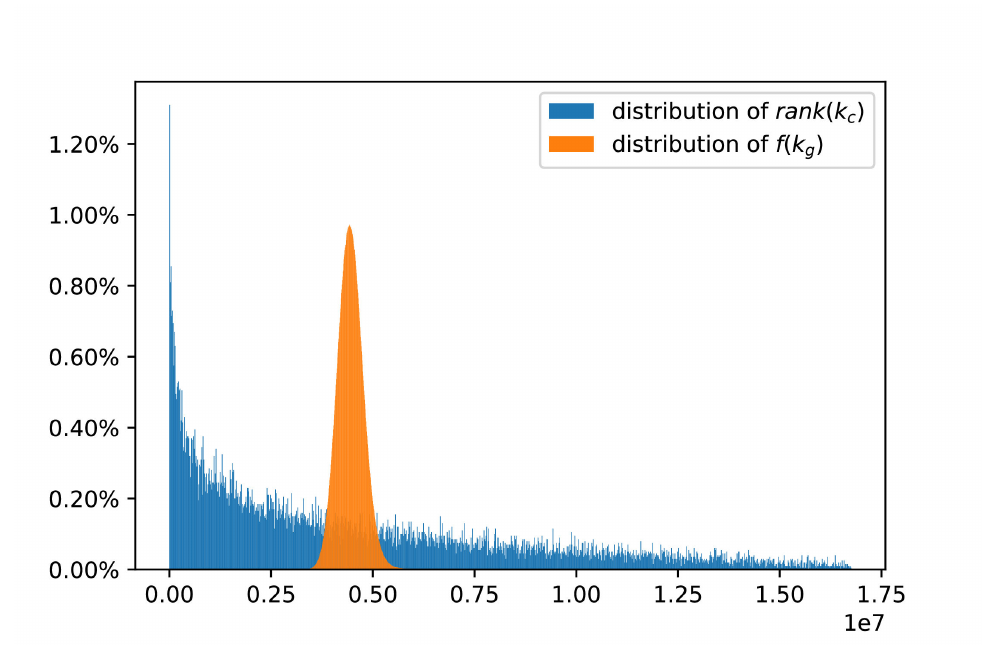
Figure 6: Distributions of rank ( k c )(blue) and f ( k g